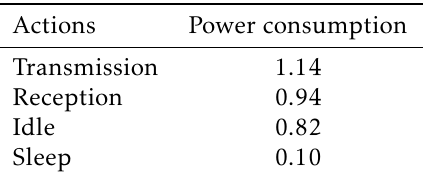
Table 3. Powerconsumptionin